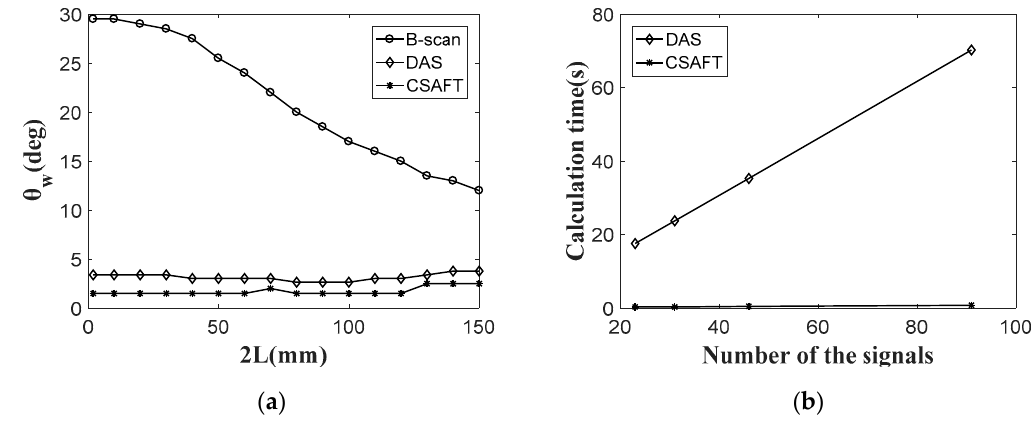
Figure 10. Comparisons of three methods with different factors: ( a ) the angular bandwidth θ w by the transducer with different lengths; ( b ) Calculation times with different numbers of signals. The excitation signal is a tone-burst signal with three cycles.